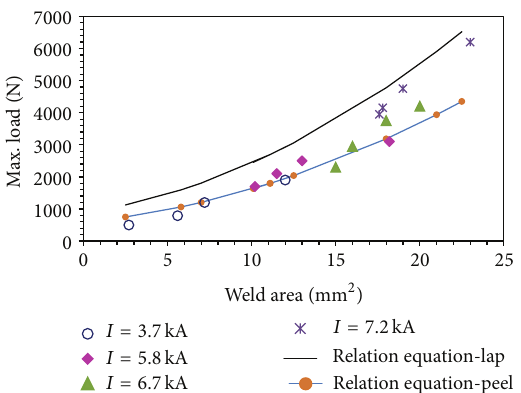
= 4mm, 𝑡 = 0.8 mm, lap joint. el